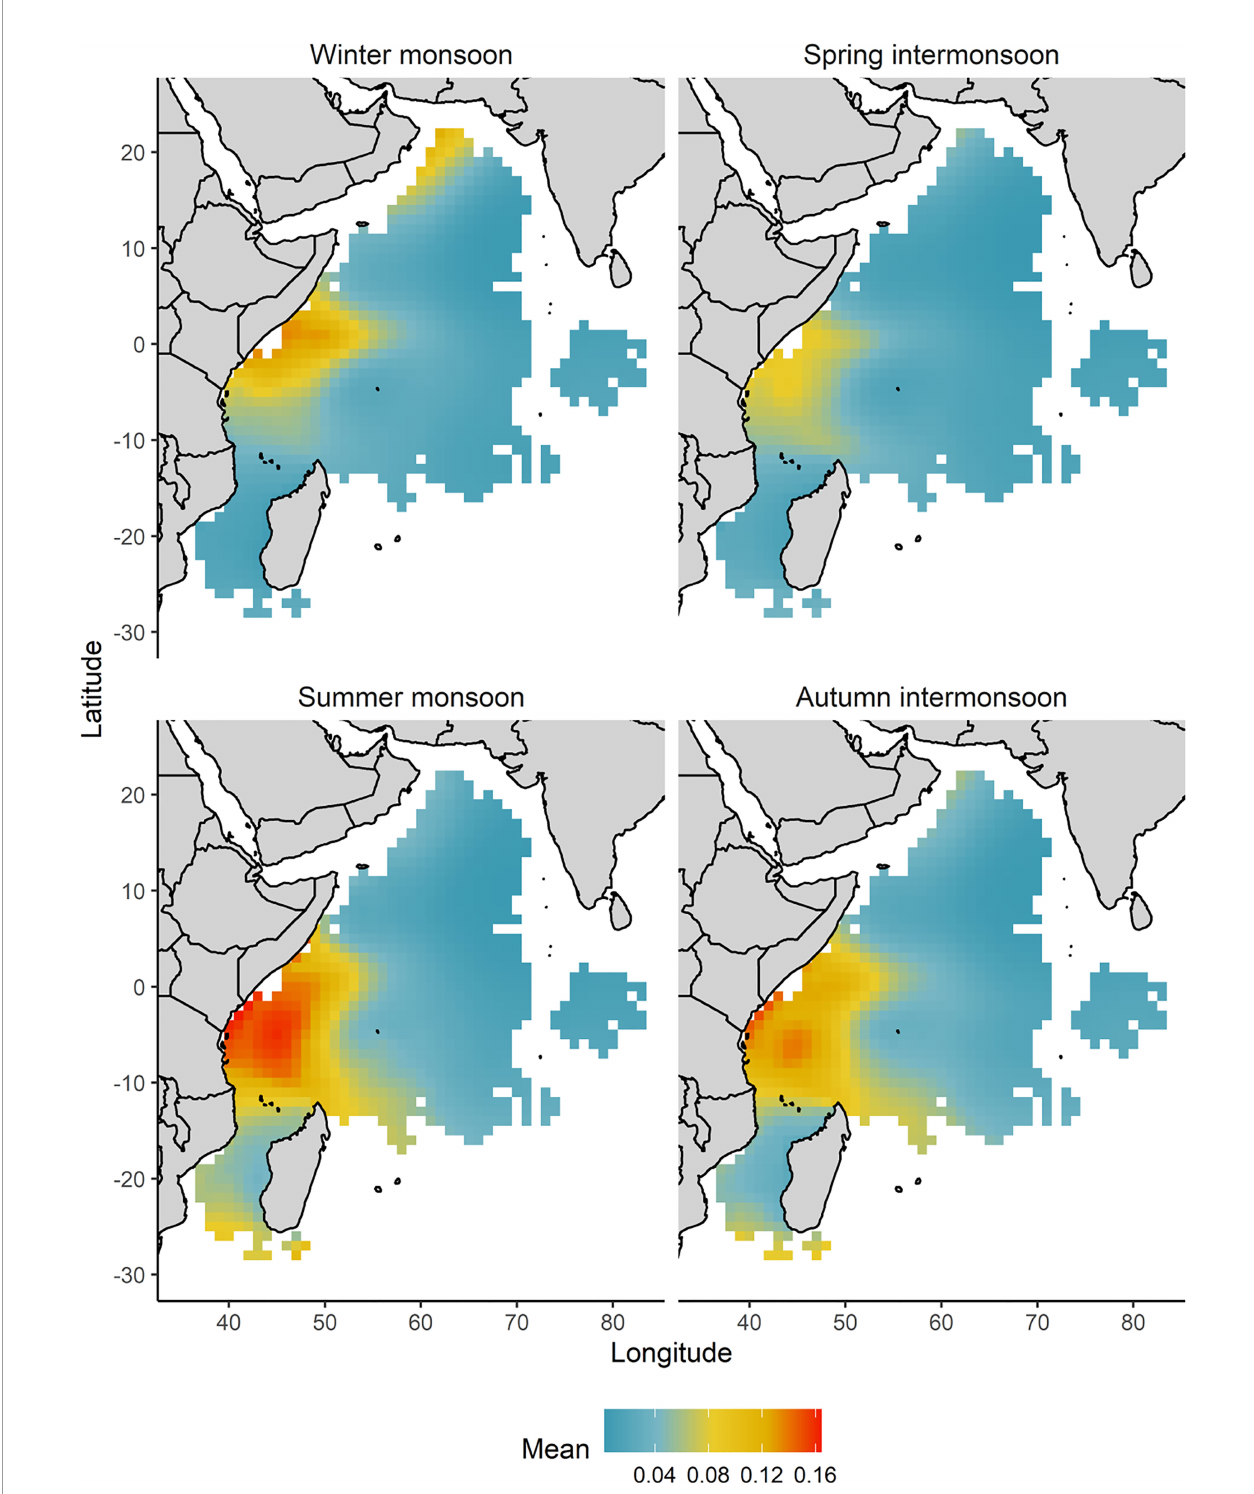
FIGURE 7 | Spatial distribution of the mean predicted catch probability of an oceanic whitetip shark by monsoon regimes and across the fi shing grounds of the tropical tuna purse seine fi shery in the western Indian Ocean. Winter monsoon (December-March), spring intermonsoon (April and May), summer monsoon (June- September) and autumn intermonsoon (October and November) in the western Indian Ocean. For predictions the FAD fi shing technique was used as